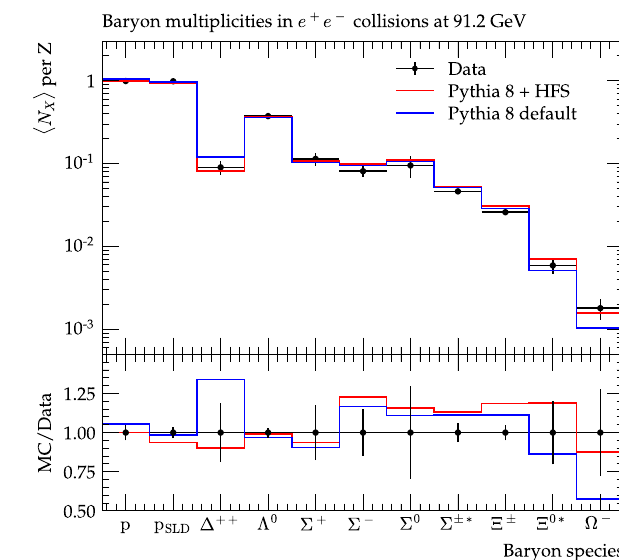
Fig. 3 Yields of identified particles (per Z) in e + e − collisions at the Z pole. Mesons to the left, and baryons to the right. The PYTHIA default tune (in blue) is compared with the model extension with reasonable